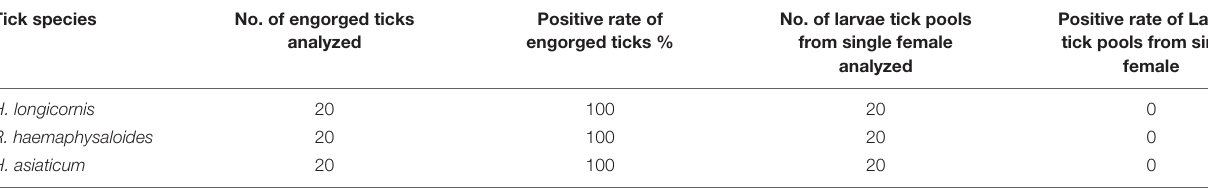
TABLE 4 | Infection of adult ticks by exposure to mice infected with B. microti. Tick species No. of engorged ticks